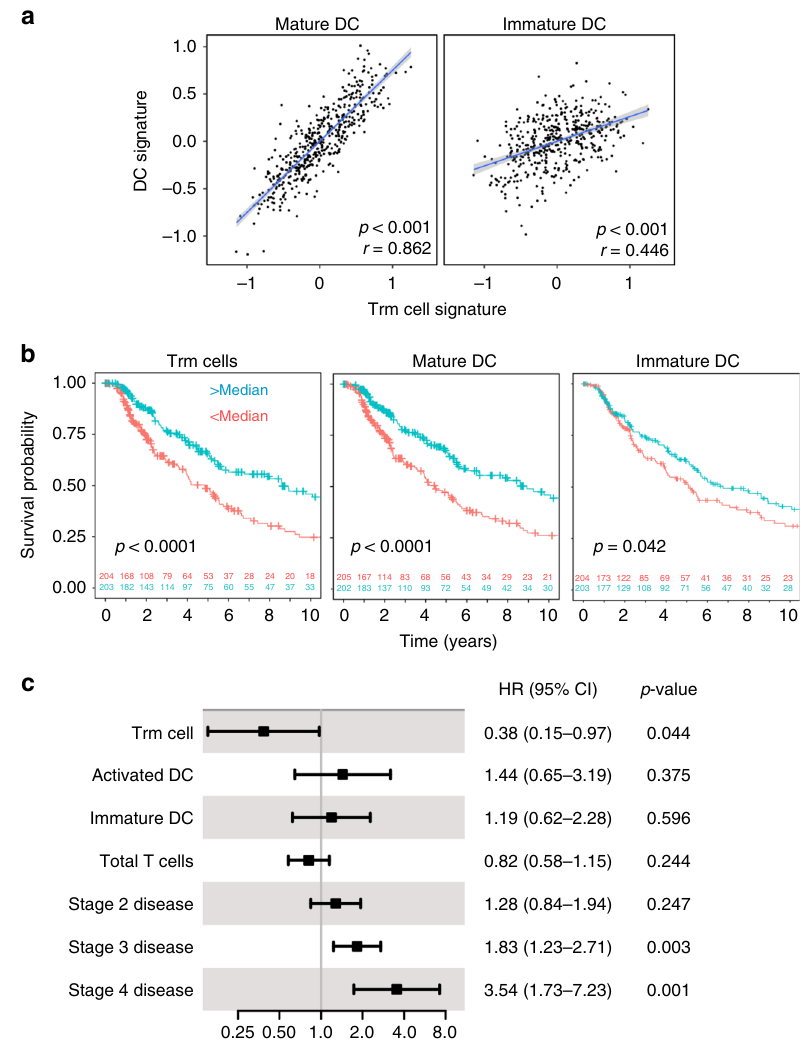
Fig. 6 Trm cell signature correlates with DC maturation and improved survival. The relationship between previously described gene transcription signatures of Trm cells, DCs and survival was investigated in the TCGA melanoma cohort. a Correlation between Trm cell gene signature and either mature or immature DC gene signatures, summarized as enrichment z-scores ( n = 468). Pearson correlation coef fi cients and associated p-values are shown. b Kaplan-Meier plots showing the overall survival of patients ( n = 407 with available data) grouped according the median value of signatures (light blue curves: upper half; red curves: lower half) corresponding to Trm cells, mature DC and immature DCs. Log-rank p-values are shown. c Multivariable Cox survival regression carried out on the same cases represented in b . The forest plot shows the hazard ratio, 95% con fi dence interval and associated p-values for each variable in the